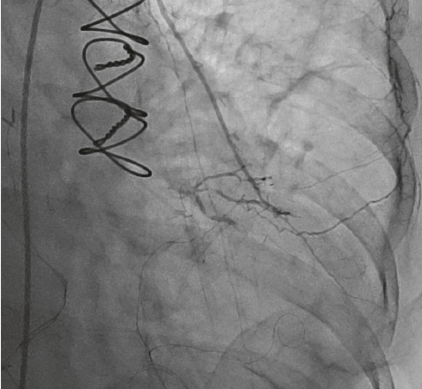
Figure 4: Left heart catheterization showing diseased LAD distal to LIMA insertion.